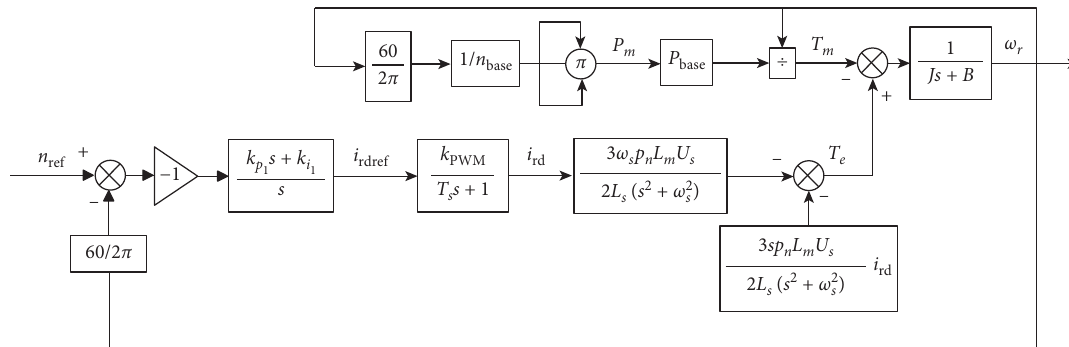
Figure 29: Block diagram of the speed priority control strategy in the pump